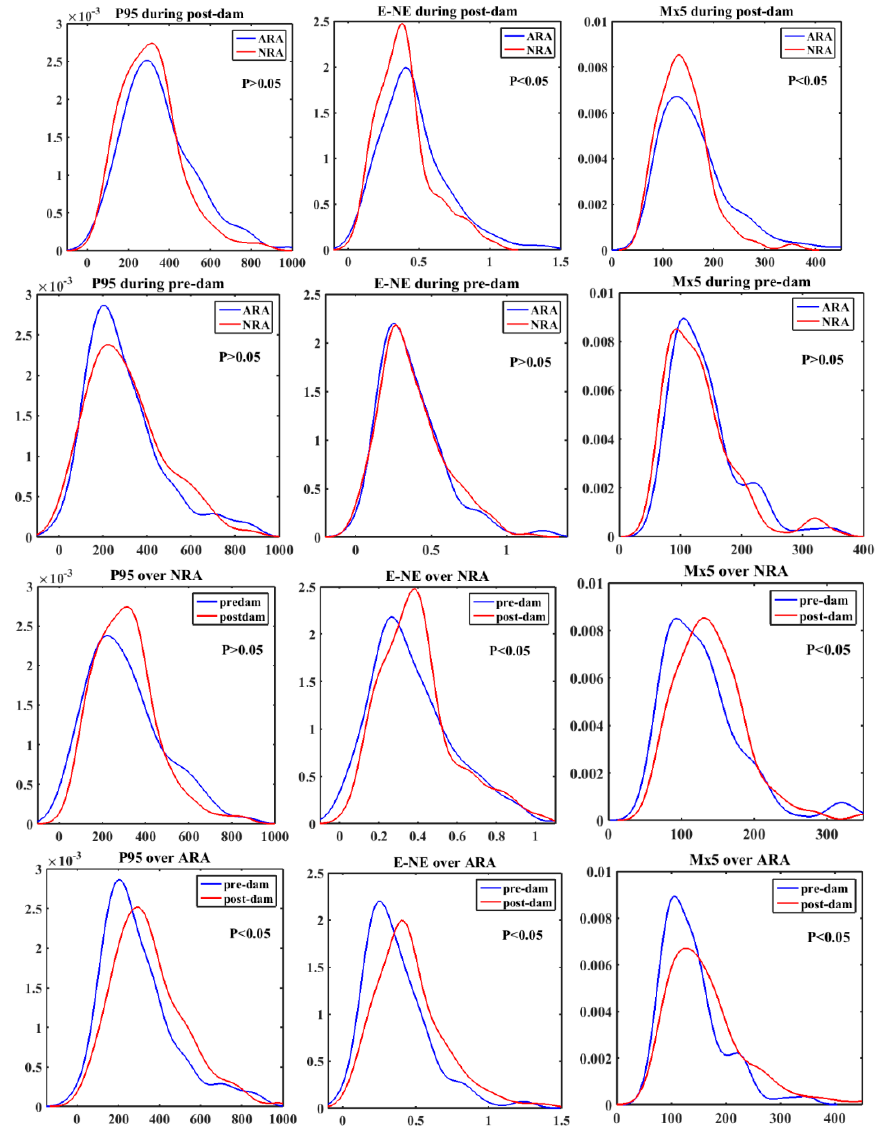
Figure 11. Density distributions for P95 , E–NE and Mx5 , respectively, for the pre- and post- dam periods, over the ARA (reservoir area) and the NRA (near reservoir area). Statistical significance was estimated using the Kolmogorov–Smirnov test for distributions of the extreme precipitation indices.